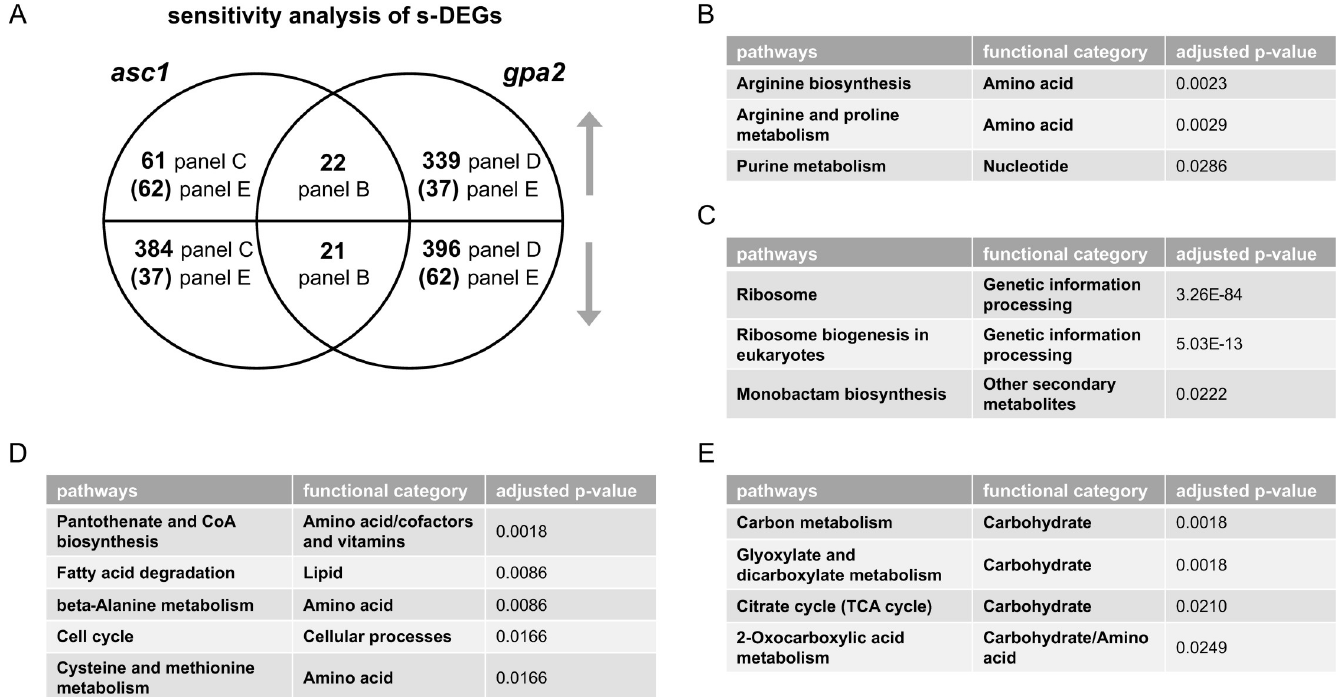
Fig 5. Sensitivity analysis of differentially expressed genes (s-DEGs) after glucose addition. A) Venn diagram of subsets of s-DEGs, before and after glucose addition for each mutant (mutantH-mutantL) and wildtype (wtH-wtL). Upper semicircle shows up-regulated s-DEGs and lower semicircle shows down-regulated s-DEGs. Numbers in parenthesis are shared s-DEGs regulated in the opposite direction, placed in the area corresponding to the direction of regulation. Subset of s-DEGs used for ORA analysis that are B) shared and change in the same direction; C) unique to asc1 ; D) unique to gpa2 ; E) shared and change in the opposite direction. Listed are all pathways and their functional categories with adjusted p-value < 0.05.